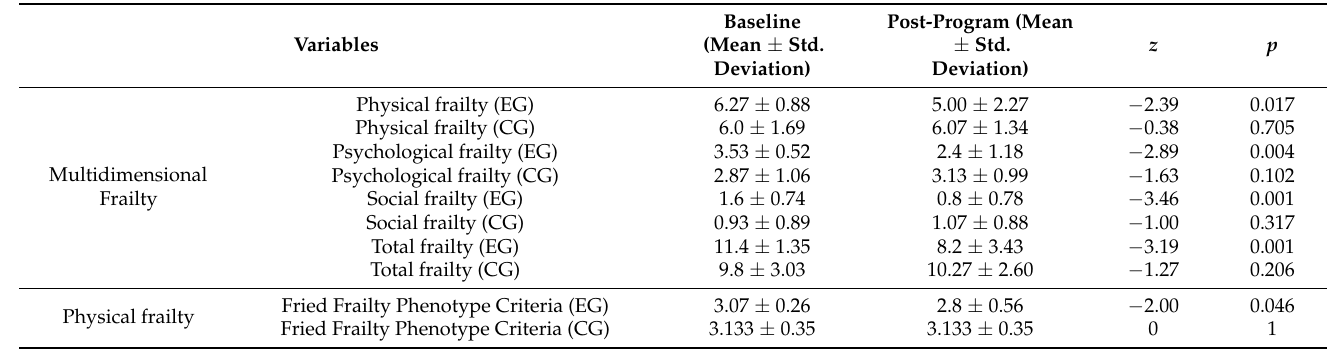
Table 3. Evaluations obtained at baseline and post-program for the variables of multidimensional frailty and physical